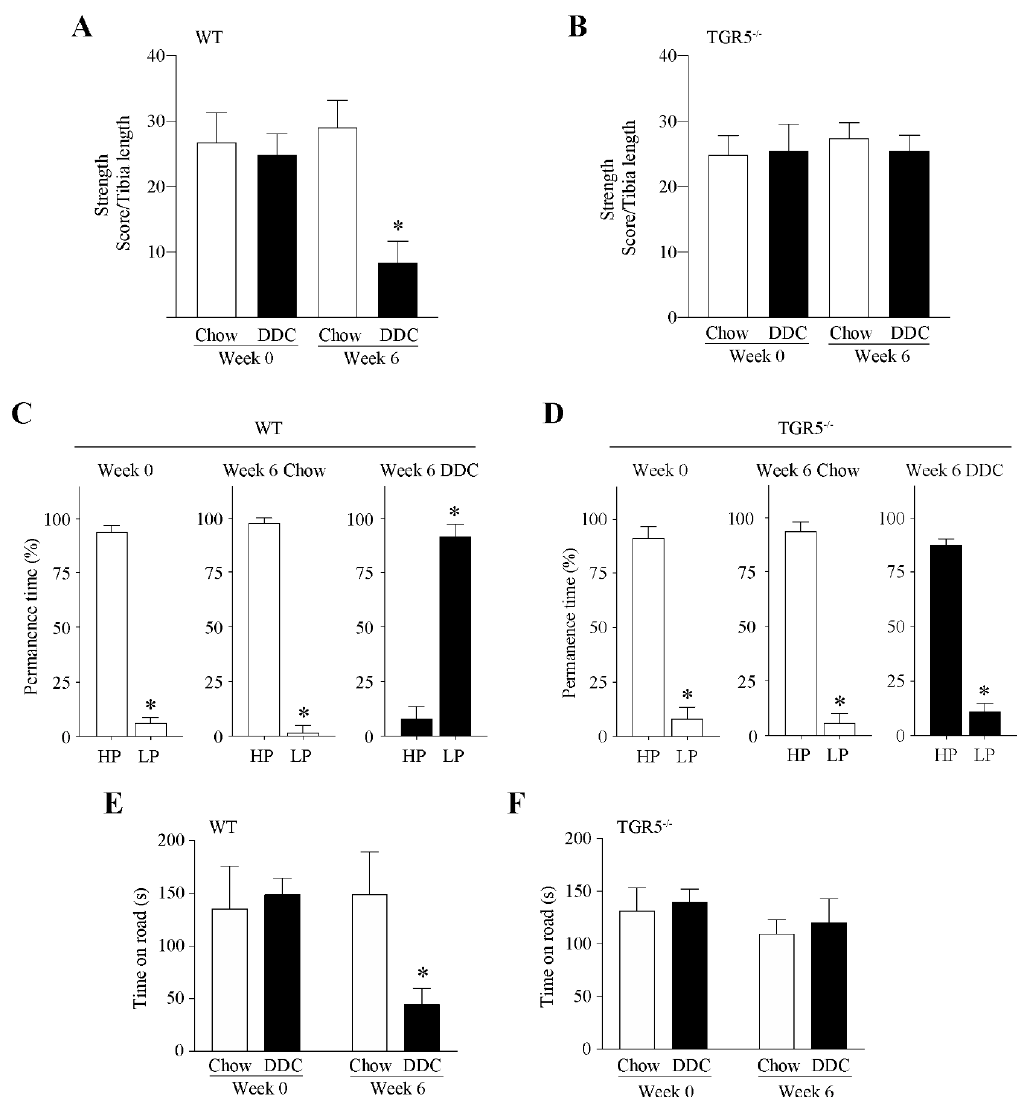
Figure 1. Muscle function declines in mice with CLD via a mechanism dependent on TGR5 expression. C57BL/6J male WT and TGR5 -/- mice were fed with a chow or a DDC-supplemented diet for 6 weeks. The weightlifting test strength measure was evaluated in WT ( A ) and TGR5 -/- ( B ) mice. The values correspond to the mean ± standard error of the mean (SEM) ( n = 7–9, * p < 0.05 vs. chow at week 0, one-way ANOVA, Tukey’s multiple comparison test). The ability to perform physical exercise was evaluated with a treadmill test in WT ( C ) and TGR5 -/- mice ( D ). The running mice were recorded by video, and the permanence time in seconds was calculated and expressed as the percentage of time spent in each zone: high (HP) and low (LP) performance zones of the treadmill ( n = 7–9, * p < 0.05 vs. WT-chow, t-test). The rotarod test was performed in WT ( E ) and TGR5 -/- ( F ) mice, and the time (s) on the rod was determined. The values correspond to the mean ± SEM ( n = 7–9, * p < 0.05 vs. chow at week 0, two-way ANOVA, Tukey’s multiple comparison test).